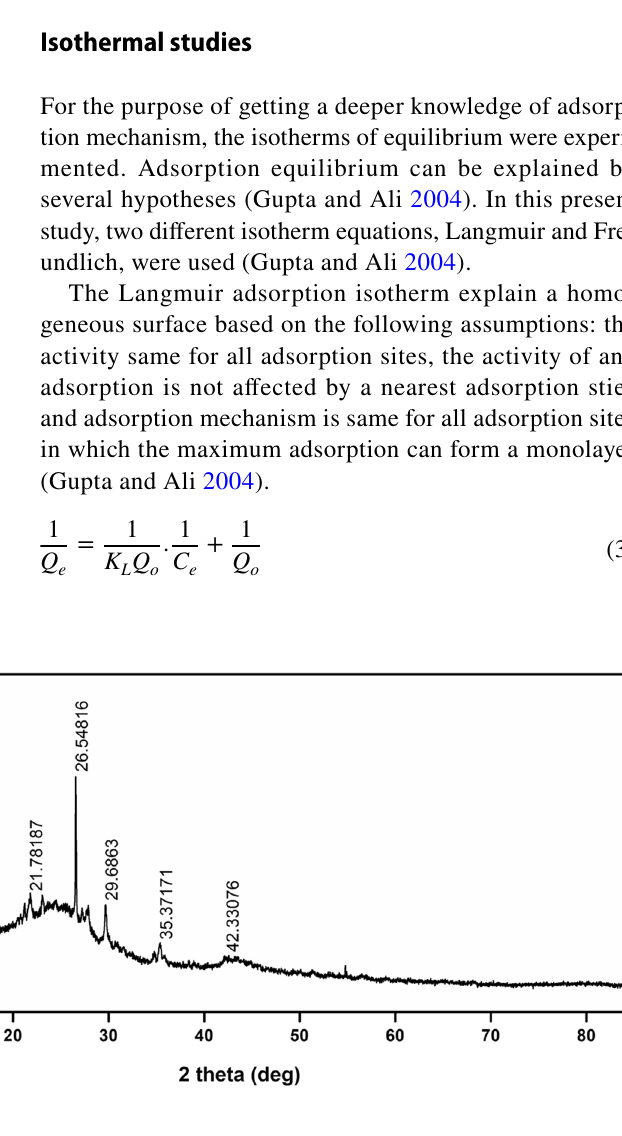
Fig. 2 SEM images of AC produced at 800 °C